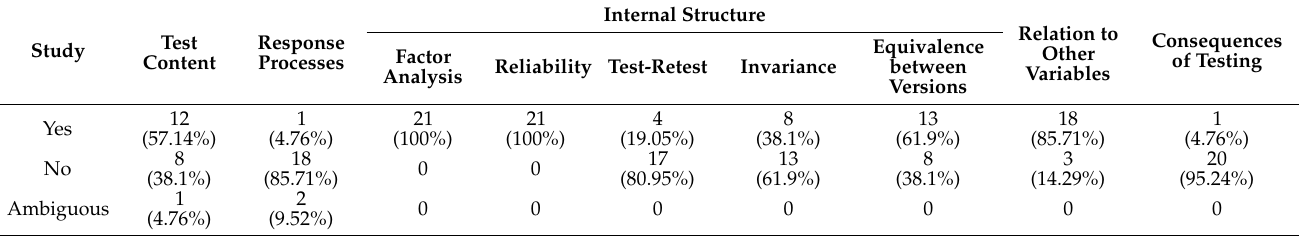
Table 1. Number of studies and percentages for each validity